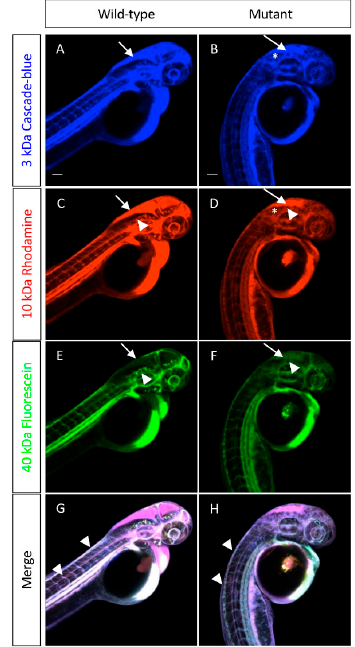
Figure 7. cp27.5 mutants express Zpr1 in the pineal gland, activated Caspase 3 in brain ventricle and eyes, and HuC in brain and spinal cord. cp27.5 wild-type and mutant larvae were intravenously injected with a mixture of a 3-kDa Cascade blue dextran, 10-kDa Rhodamine dextran, and 40-kDa Fluorescein dextran at 2 dpf. ( A ) The 3-kDa Cascade blue dextran is permeable to the brain ventricle in wild-type (arrow), but is restricted from the brain and eye (asterisks). ( B ) The 3-kDa Cascade blue dextran is retained in the brain ventricle (arrow), but also leaks into the surrounding tissue (asterisks) in mutants. ( C ) The 10-kDa Rhodamine dextran is permeable to the brain ventricle (arrow), but is also restricted from the brain and eye (asterisks) in wild-type. However, the 10-kDa Rhodamine dextran is more restricted to the brain vasculature compared to the 3-kDa Cascade blue (arrowhead). ( D ) The 10-kDa Rhodamine dextran is permeable to the brain ventricle (arrow), but also leaks into the surrounding tissue (asterisks) and is not restricted to the brain vasculature in mutants (arrowhead). ( E ) The 40-kDa Fluorescein dextran has little to no tracer leakage into the brain ventricle (arrow) and is restricted from entering the brain and eye (asterisk) in wild-type. The tracer is also retained within the brain vasculature (arrowhead). ( F ) In mutants, the 40-kDa Fluorescein dextran is slightly permeable to the brain ventricle (arrow), but not as severe compared to the 3-kDa Cascade blue and 10-kDa Rhodamine dextran. The tracer does not appear to leak into the brain, eye, or surrounding tissue as severely as the smaller tracers; however, there is still absence of the tracer retained within the brain vasculature (arrowhead). ( G ) Merged image of wild-type larvae coinjected with all three tracers. ( H ) Merged image of mutant larvae coinjected with all three tracers. Tracers are retained within the peripheral tail vasculature in mutants comparable to wild-type (arrowheads). Scale bars are 50 µ